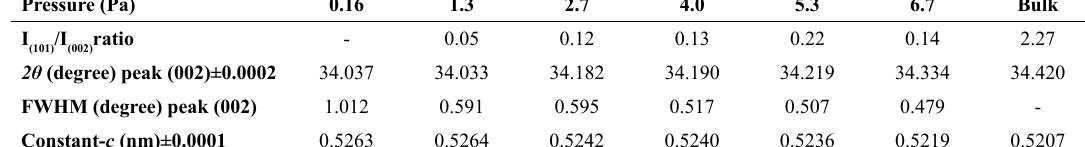
FWHM (degree) peak (002)